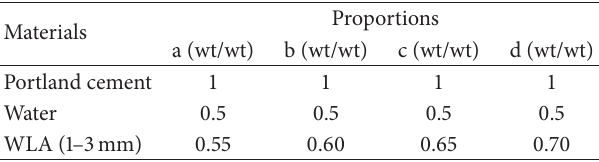
Table 1: Proportions ratio of LC samples preparation with WLA.